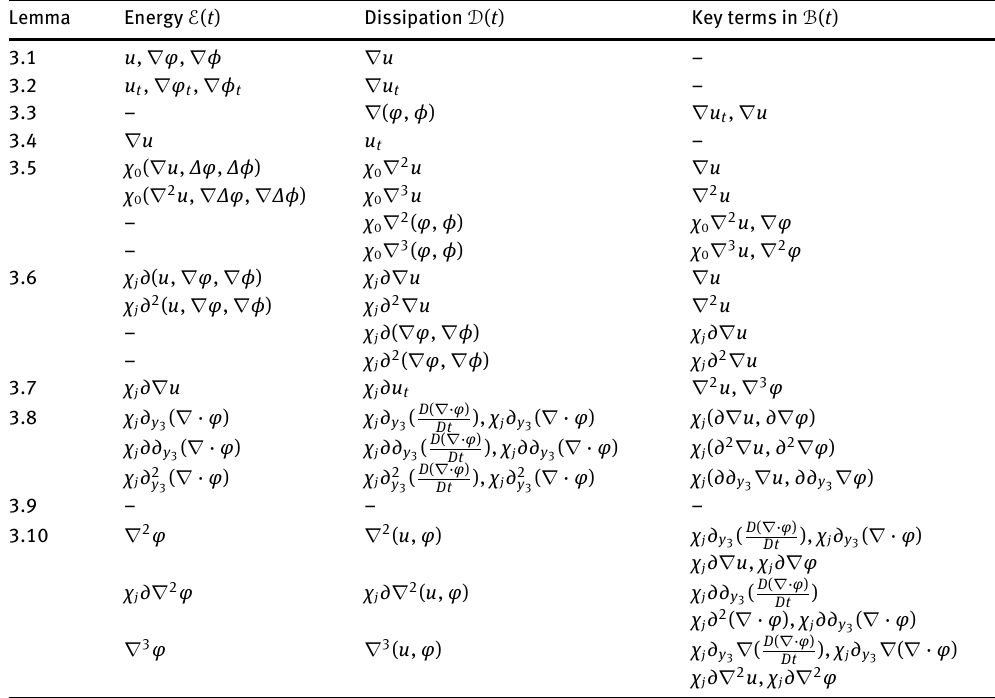
Table 1: List of Energy